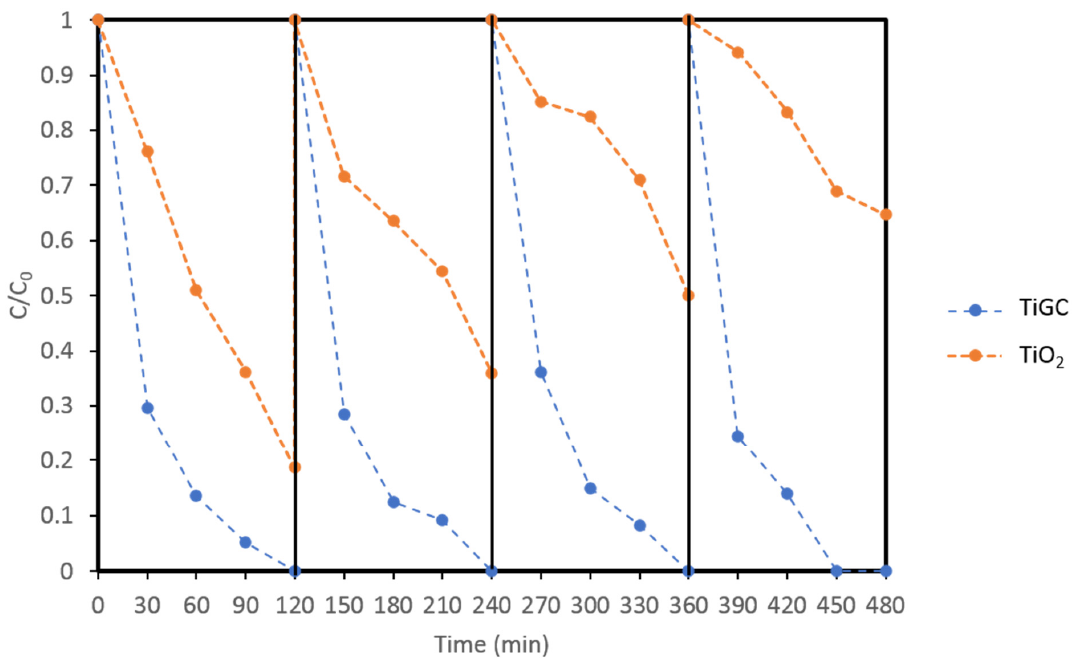
Figure 4. Comparison of CBZ removal by TiGC (TiO 2 :GO ratio 2:1) and bare TiO 2 over repeated cycles of CBZ addition. CBZ initial concentration per cycle: 1 mg/L, 1000 W Xenon lamp supplied illumination.